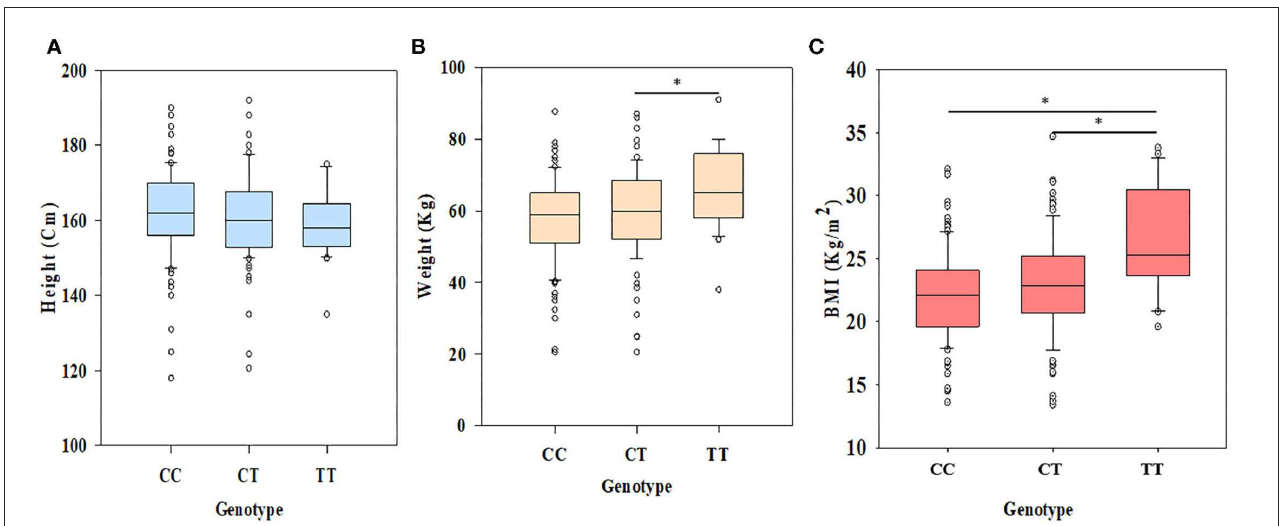
FIGURE2 Results of ANOVA among different genotypes for morphometric traits. (A) No significant difference ( p = 0.172) was observed in the case of height among genotypes, but (B) showing significant difference ( p = 0.015) for weight between CT and TT, and (C) BMI between CC and TT ( p < 0.001) and CT and TT ( p = 0.002), respectively ( * p <